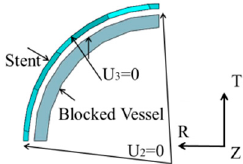
Figure 7. Loading conditions for the expansion model.